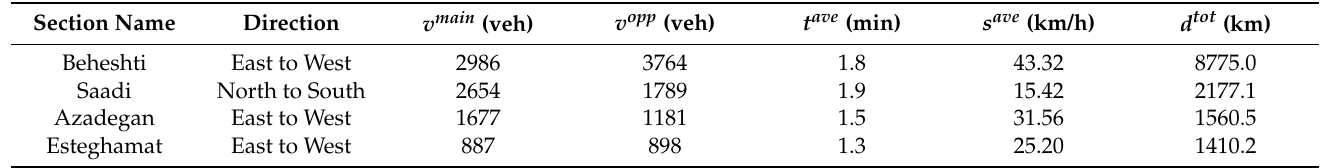
Table 5. The peak hour indicators for the selected roadway